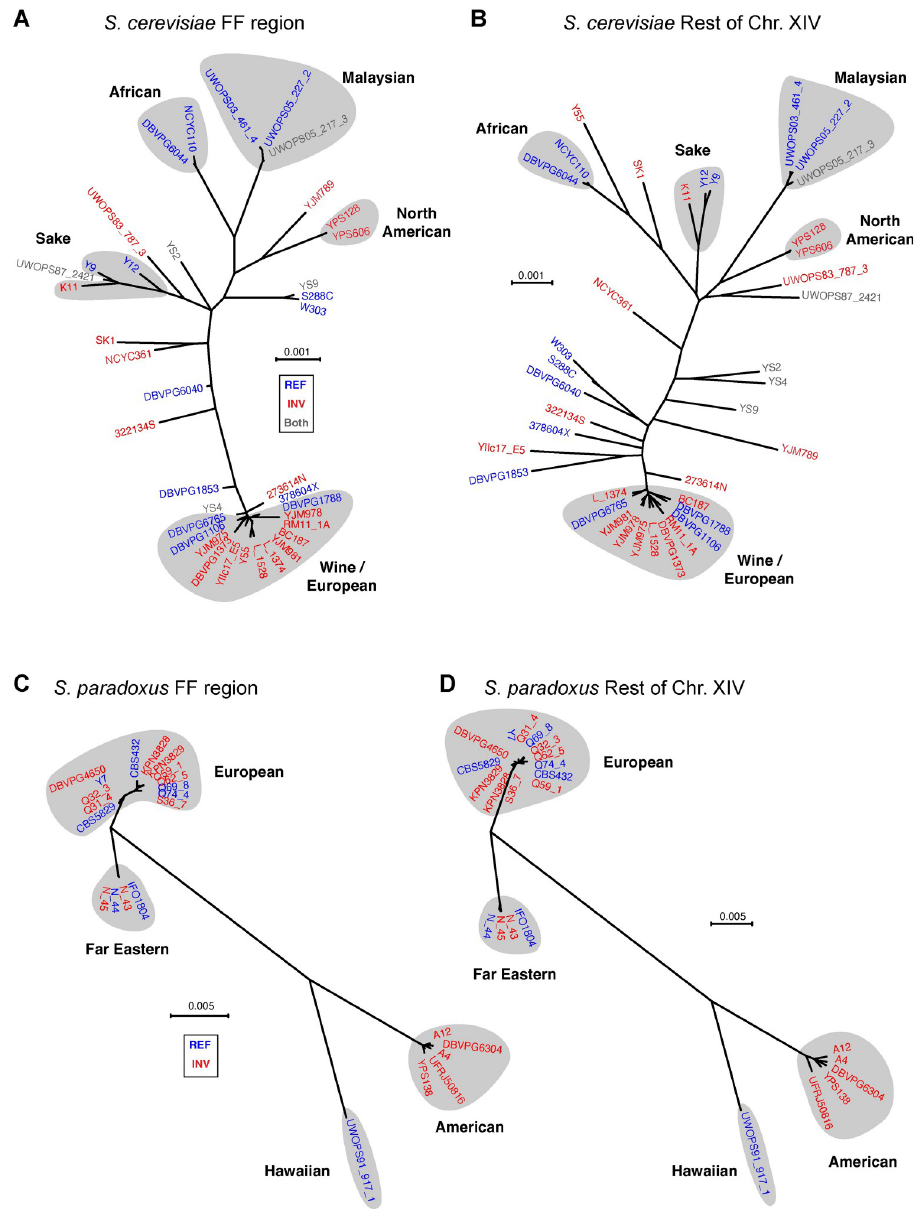
Fig 4. Phylogenetic analysis of parts of chromosome XIV shows that inversions of the FF region have occurred multiple times in S . cerevisiae and S . paradoxus . (A) S . cerevisiae tree constructed from the FF region. (B) S . cerevisiae tree constructed from the rest of chromosome XIV excluding the FF region and the IRs. (C) S . paradoxus tree constructed from the FF region. (D) S . paradoxus tree constructed from the rest of chromosome XIV excluding the FF region and the IRs. Strain names are shown in blue for REF orientations, red for INV orientations, and gray for strains that produced both REF and INV products in PCR assays. Phylogenetic trees were constructed as described in Materials and